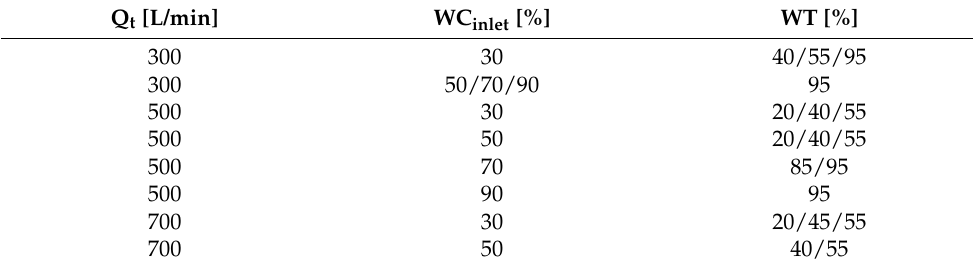
Table 2. Unspiked Exxsol D60 Experimental campaign infill test matrix.